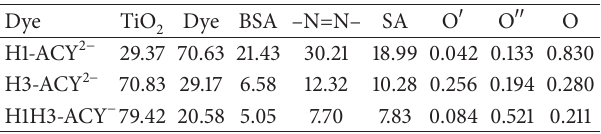
Table 6: Contributions of various groups, in %, to the electron densityoftheMOcorrespondingtotheexcitedstateofthesensitizer, calculated at DFT/B3LYP/DZVP level.